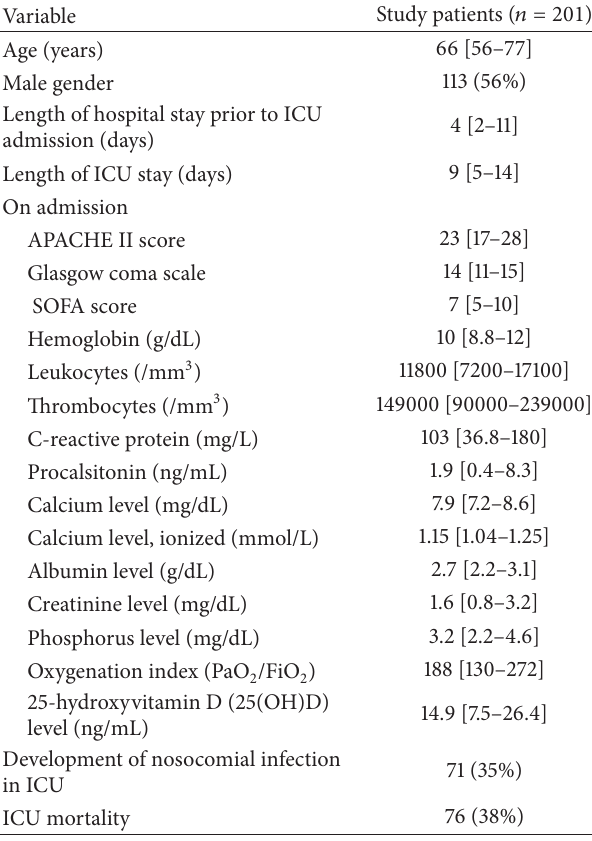
Table 1: Some baseline characteristics of study patients.